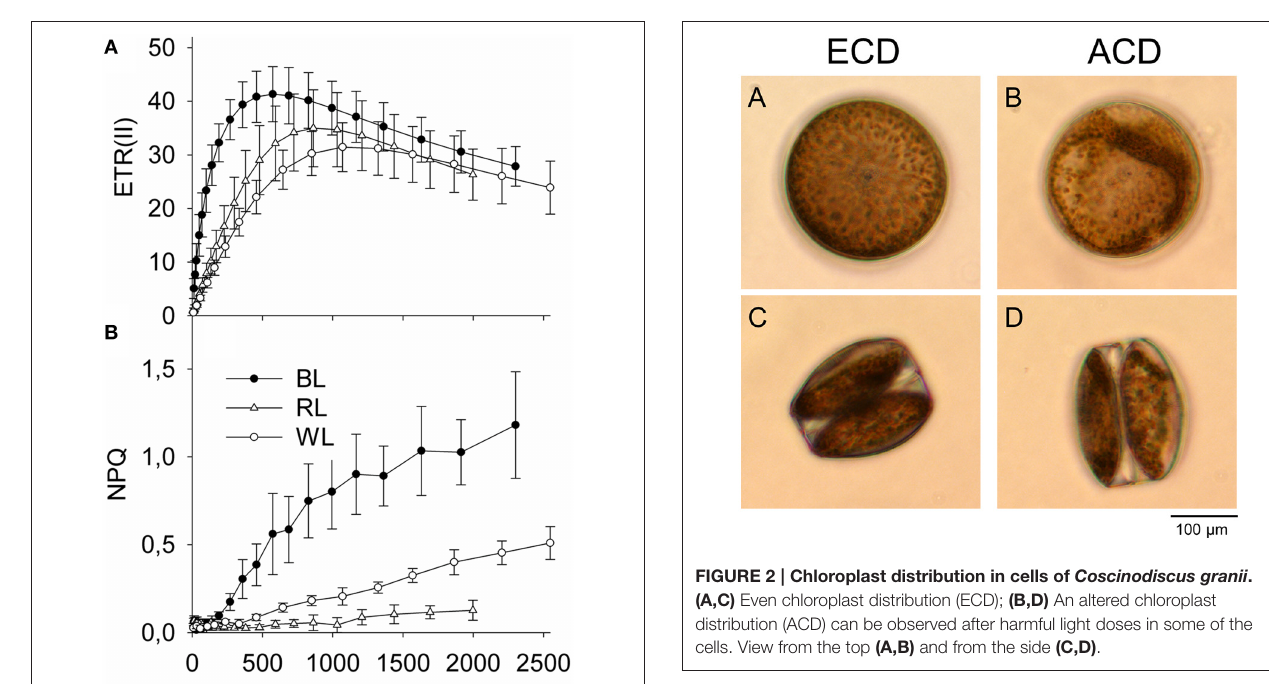
FIGURE 1 | Rapid chlorophyll fluorescence light-response curves of Coscinodiscus granii under blue, red, and white light. (A) Absolute PSII electron transport rates, ETR; (B) Non photochemical quenching, NPQ. Average values and standard error ( n = 3 ) are indicated. [ F (1 , 23) = 31.778; p < 0.001; Figure 3C ], and in the presence of BDM cells with an altered chloroplast distribution increased further after a 20 h dark recovery period [ F (1 , 23) = 29.153; p < 0.001].